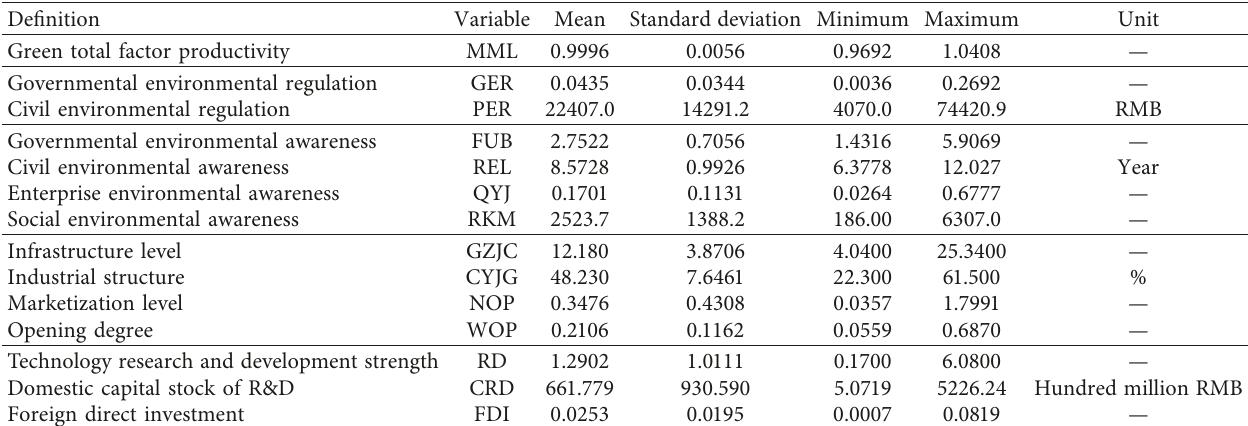
Table 3: Descriptions of all variables.